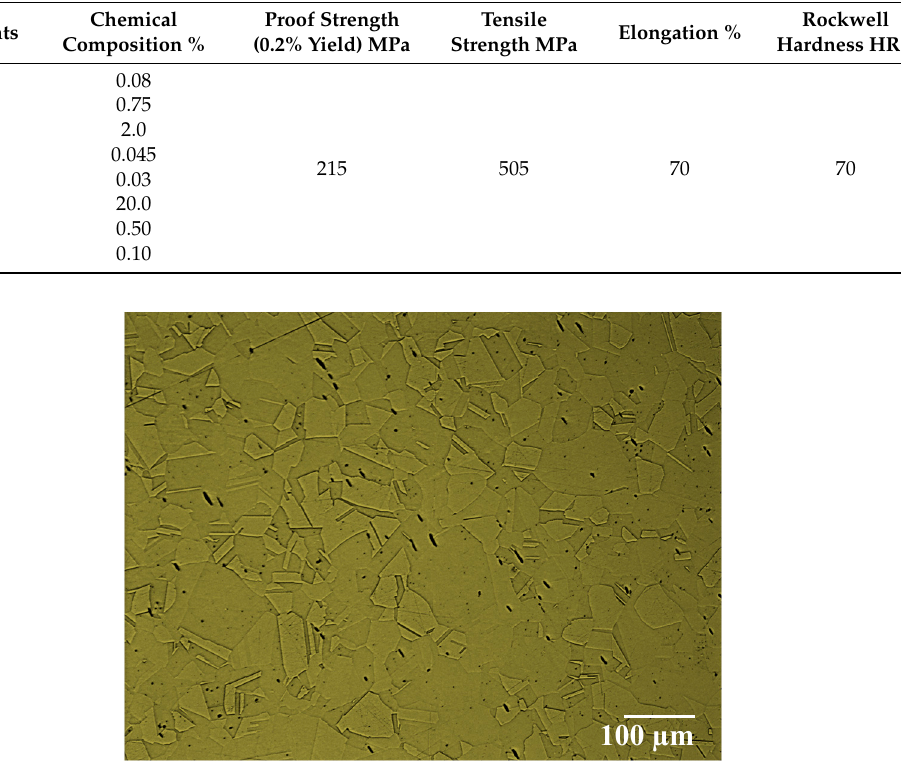
Figure 1. The microstructure of AISI 304 with an austenitic structure.